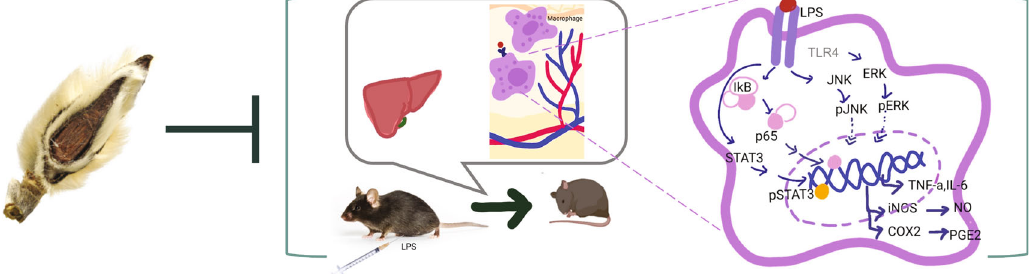
Figure 7: Schematic summarizing the cell signaling cascades a ff ected by MF in LPS-induced in fl ammatory responses in septic model and RAW264.7